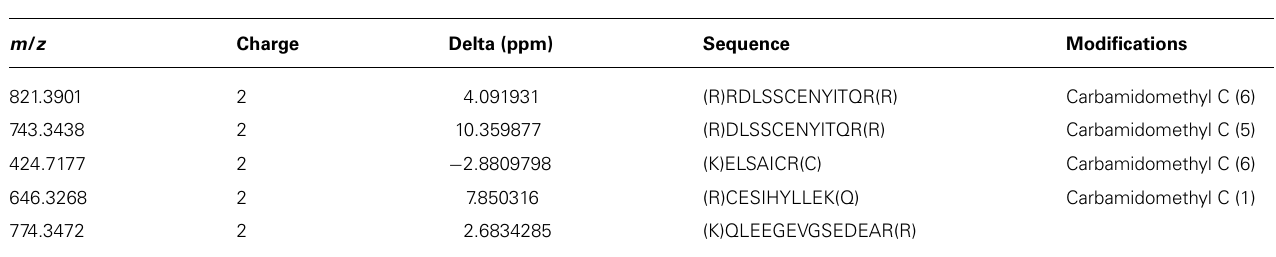
Table 3 | Peptide sequences of JcTI-I identified after data-dependent acquisition (DDA)